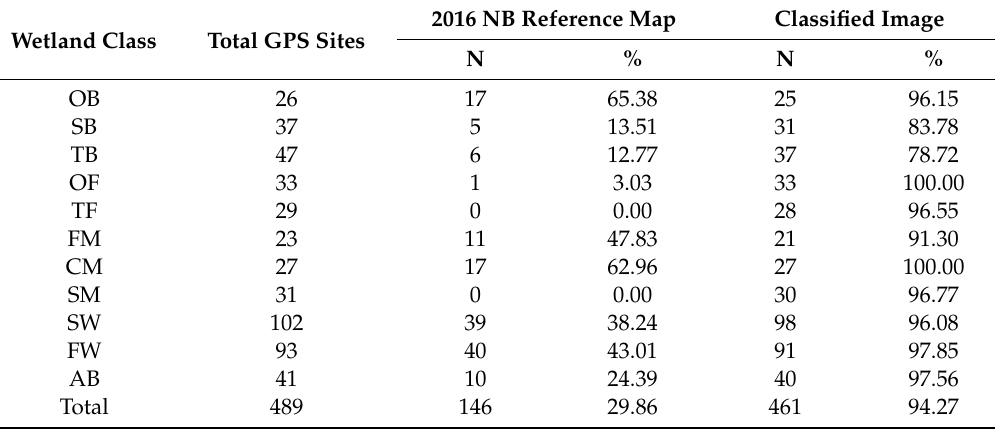
Table 14. Comparison between the 2016 NB reference map and classified image for the number and percentage of the 489 in-situ GPS wetland sites that were correctly identified as a function of the wetland